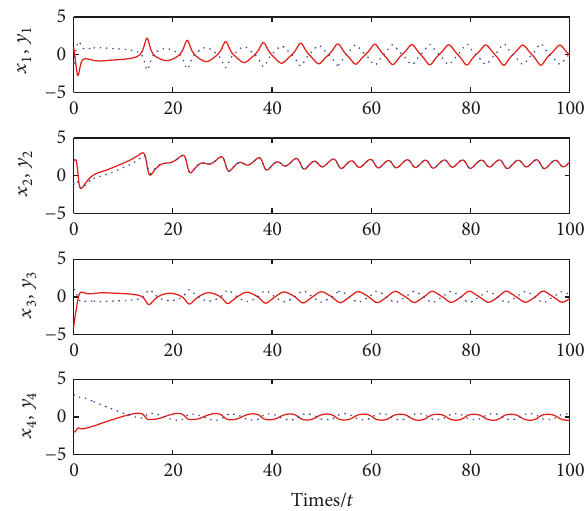
Figure 10: The figure shows that states 𝑥 1 , 𝑥 3 ,𝑥 4 antisynchronize states 𝑦 1 , 𝑦 3 , 𝑦 4 , while state 𝑥 2 synchronizes state 𝑦 2 , respectively.